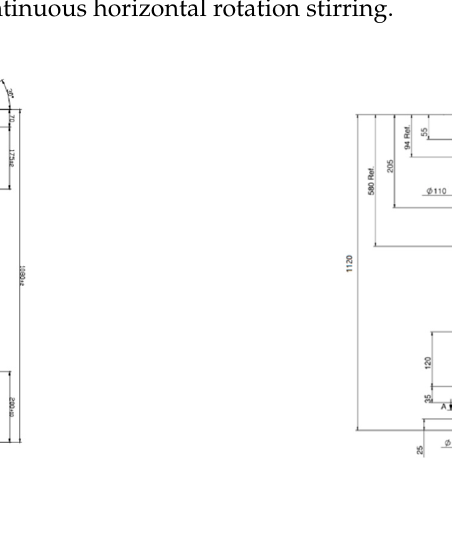
Figure 1. Schematic diagrams of ( a ) single-port nozzle and ( b ) five-port nozzle.